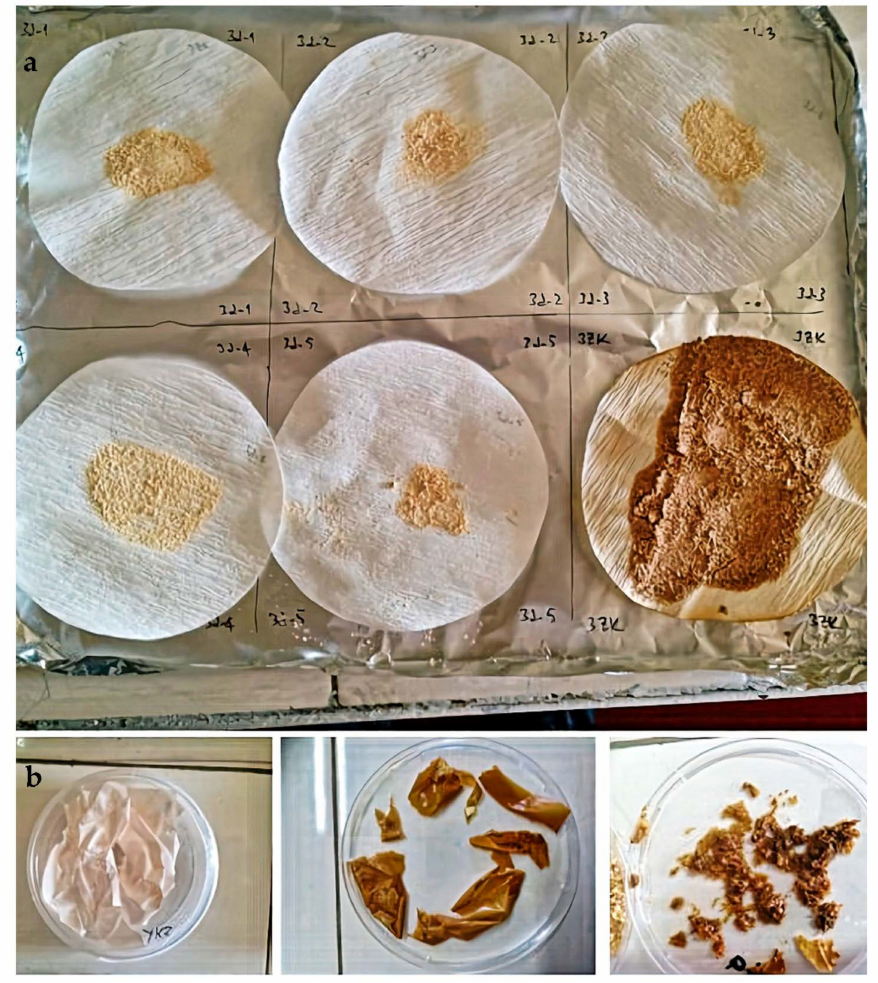
Figure 9. Images of eggshell membrane ( a ) from foam separation process; ( b ) before and after OLE adsorption in a batch